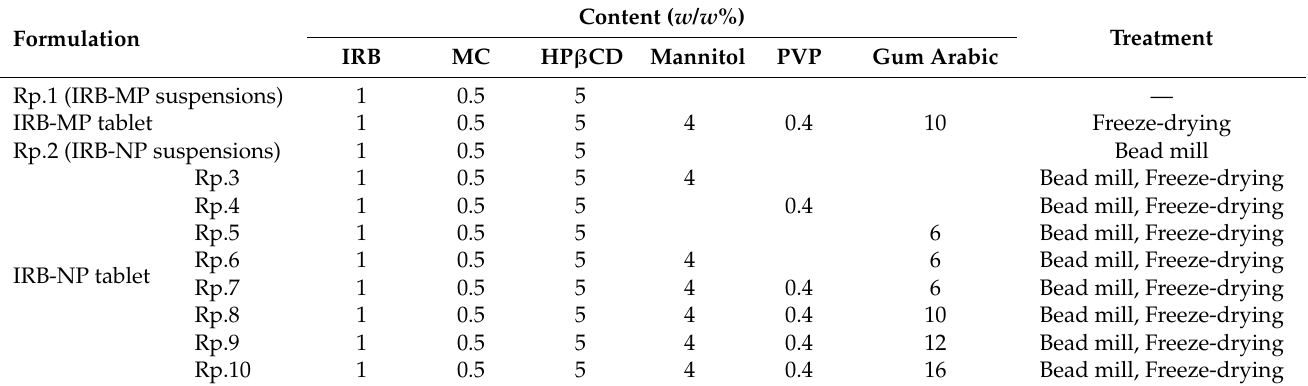
Table 1. Compositions of IRB suspensions used to prepare the tablet in this